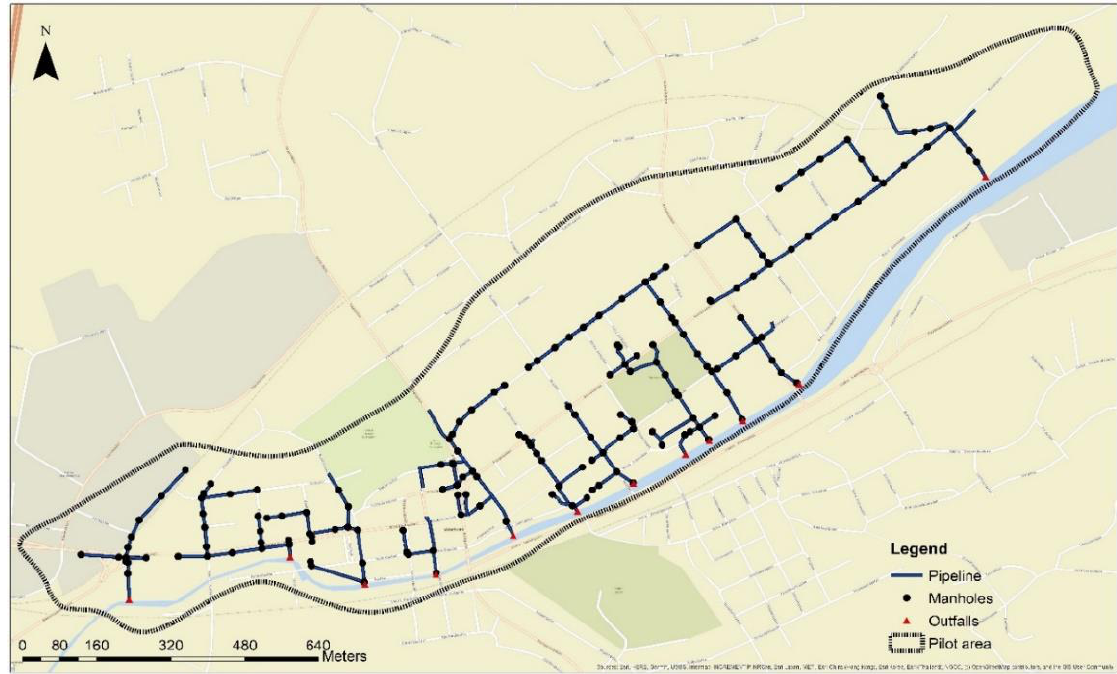
Figure 6. Söderhamn case study area.